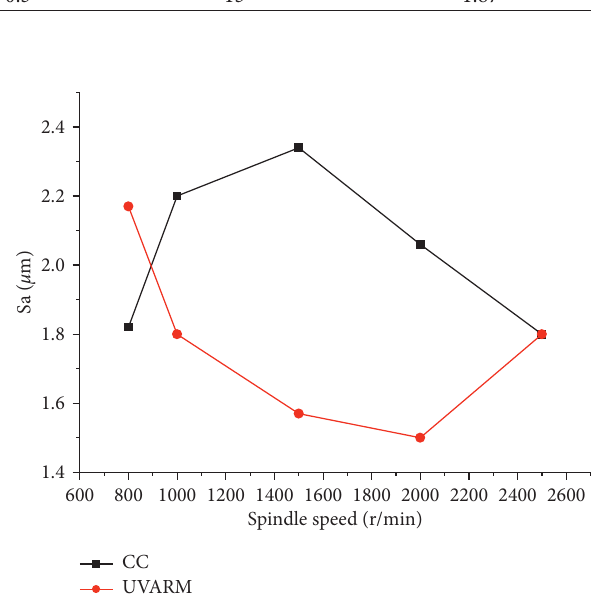
Figure 23: The behavior of surface roughness with the spindle